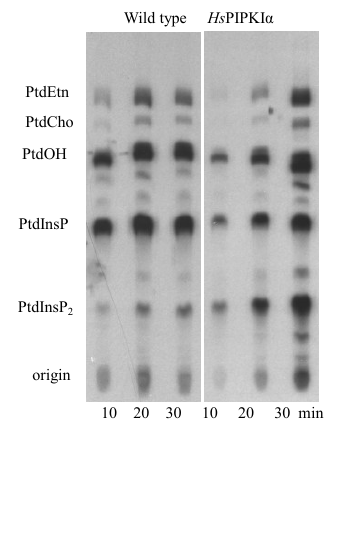
Figure 5. In vivo labeling studies with 32 Pi indicate a rapid rate of [ 32 P]PtdInsP biosynthesis in the Hs PIPKIα lines. 13 or 17-d-old seedlings were pre-equilibrated in MS medium overnight; 32 Pi (50 μCi per sample) was added, the seedlings were harvested, and lipids were extracted at the time points indicated. The lipids were separated by TLC, and 32 P-labeled lipids were quantified with a Bioscan imaging scanner. ( A ) Representative autoradiogram of the TLC plate; ( B , C , and D ) show 32 P recovered phospholipids (PtdInsP , PtdInsP, and PtdOH, respectively) over the time course. The data are reported as 2 percentage of total cpm recovered per lane. Each point is the average ± SD of duplicates from two or three independent experiments except for GFP which is the average ± SD of duplicates from one